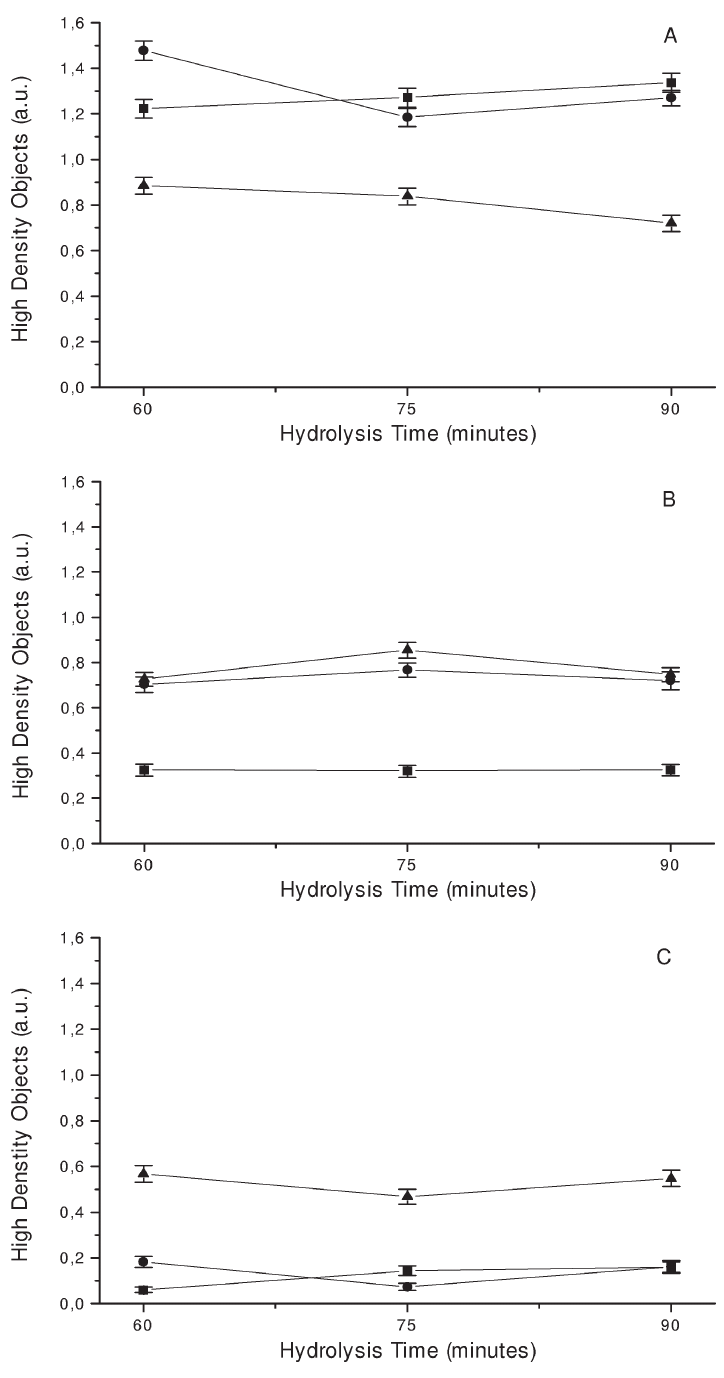
Fig. 3. Mean values ( (cid:6) SEM) of high density objects in the plateau range of hydrolysis curve for lymphatic cells (A), ep- ithelial cells from buccal mucosa (B) and uterine myometrial cells (C) fixed by different types of fixatives: (cid:4) – Delaunay, (cid:15) – Saccomanno, N –